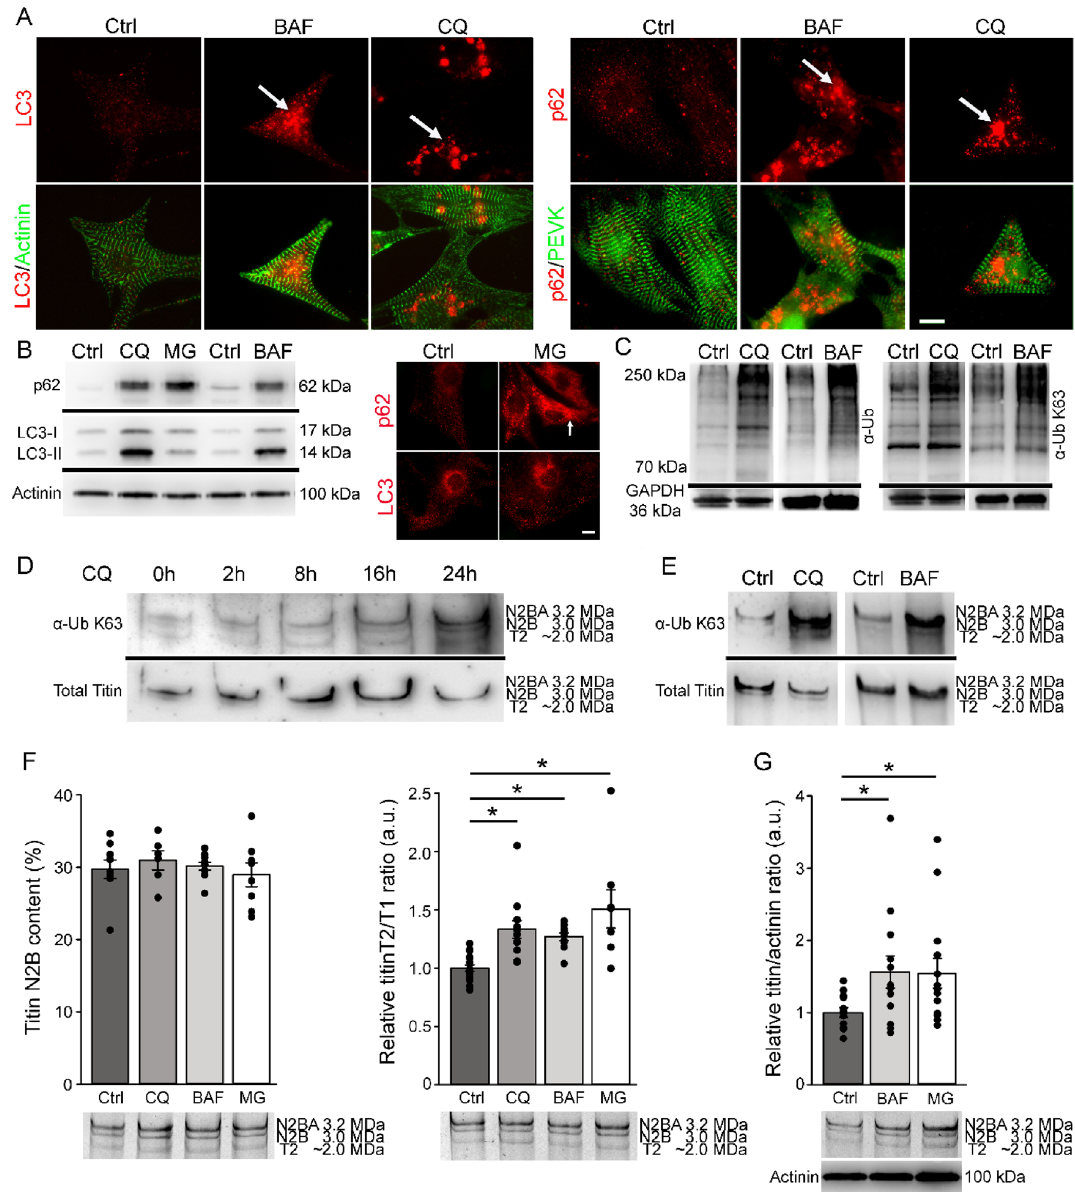
Figure 1. Autophagy and proteasomal inhibition in ERCs induced general protein and full-length titin ubiquitination and increased the level of total titin and titin degradation intermediates. Autophagy related marker proteins LC3 and p62 were investigated under basal conditions and after 24 h of inhibition with CQ, BAF or MG132 by immunofluorescence ( A / B ) and Western blot ( B ). ( C ) Protein ubiquitination in the molecular weight range of ~ 70–250 kDa using total ubiquitin and K63-polyubiquitin antibodies. ( D / E ) Total ubiquitination and K63-polyubiquitination of titin under control conditions and after autophagy inhibition. ( F ) N2B titin content and relative T2/T1 ratio of ERCs at cultivation day 3 under control conditions and 24 h inhibition of autophagy or the proteasome. ( G ) Relative titin/actinin ratio under control conditions and after autophagy or proteasomal inhibition. An antibody targeting titin PEVK was used in immunofluorescence as cardiomyocyte marker and in titin blot as a marker for titin loading (Total Titin). GAPDH and α-actinin antibodies were used as loading marker for standard Western blots. Data are shown as mean ± SEM (n = 6–17 for T2/T1; n = 13–14 for titin/actinin ratio). Asterisks ( P < 0.05 in one-way ANOVA with Dunn`s multiple comparison) mark statistical significance. BAF = bafilomycin; Ctrl = control; MG = proteasomal inhibitor MG132; α-Ub = anti-Ubiquitin antibody; α-Ub K63 = anti-K63-polyubiquitin antibody; N2B and N2BA = cardiac titin isoforms; T2 = specific titin degradation band. Bars = 10